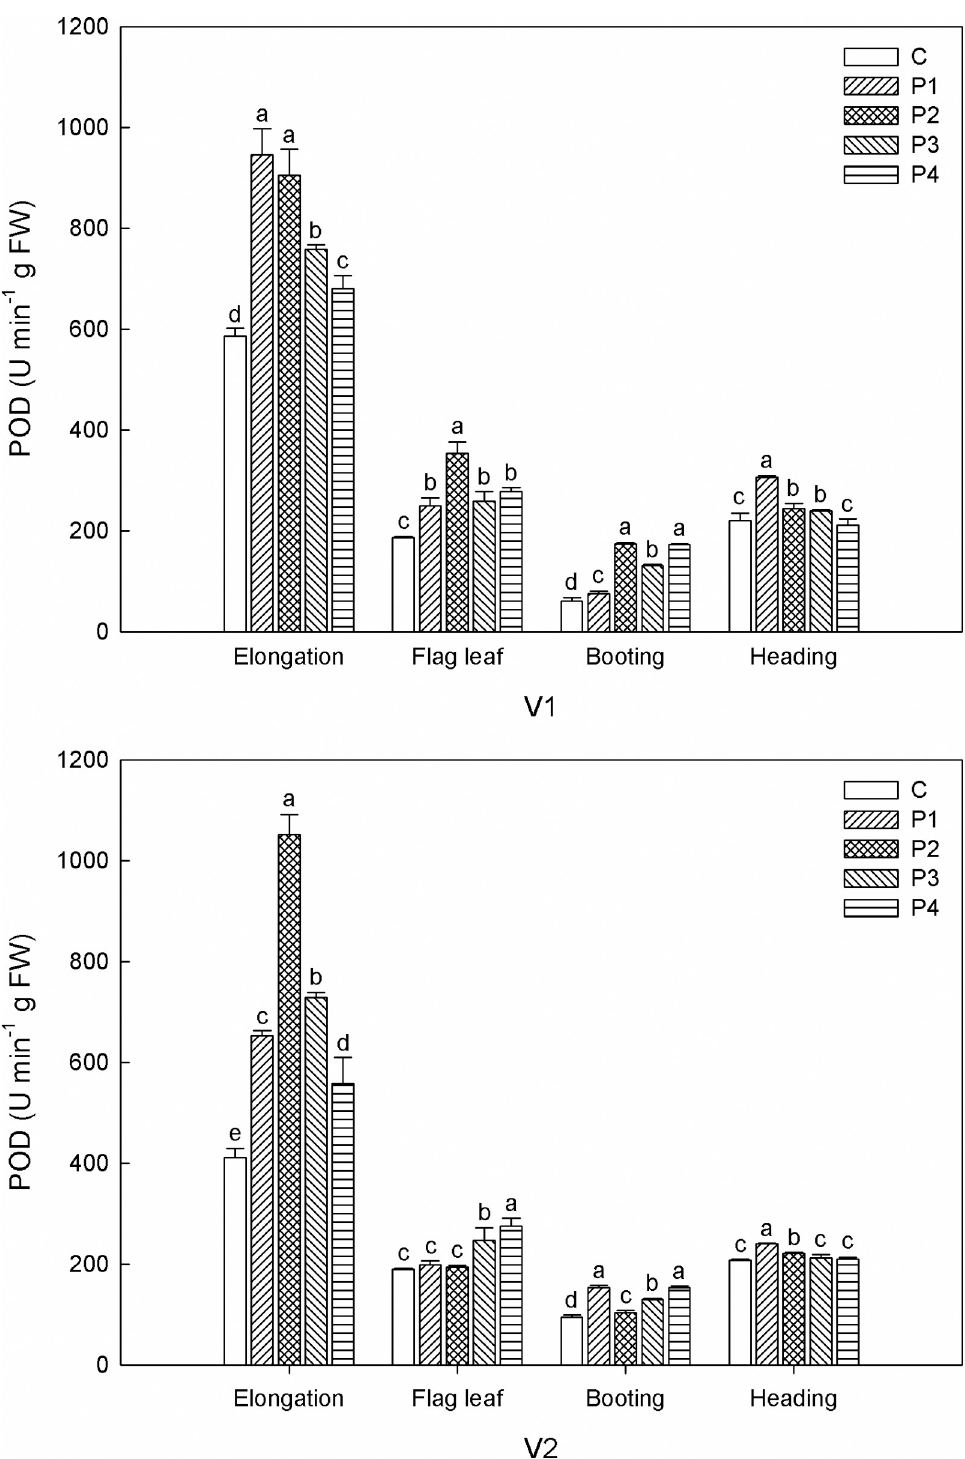
Fig 2. Effects of seed priming on POD under salt stress at different growth stages. V1: CFSH30, V2: 1230, C: control, P1: H 2 O 2 , P2: NaCl, P3: KCl, P4: MgSO 4 . Within the same growth stage, the bars marked with different lowercase letters are statistically different at the 0.05 probability level.